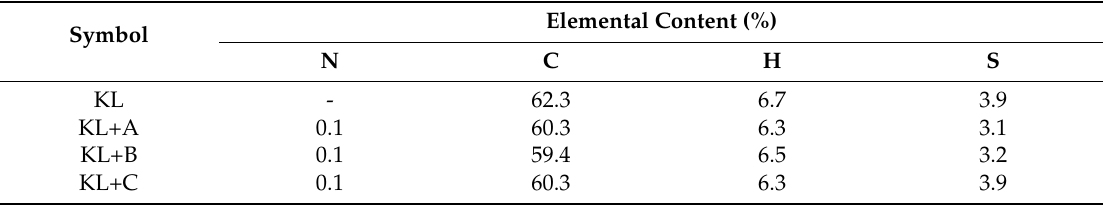
Table 2. Elemental content of kraft lignin (KL) and lignin activated in selected ionic liquids: